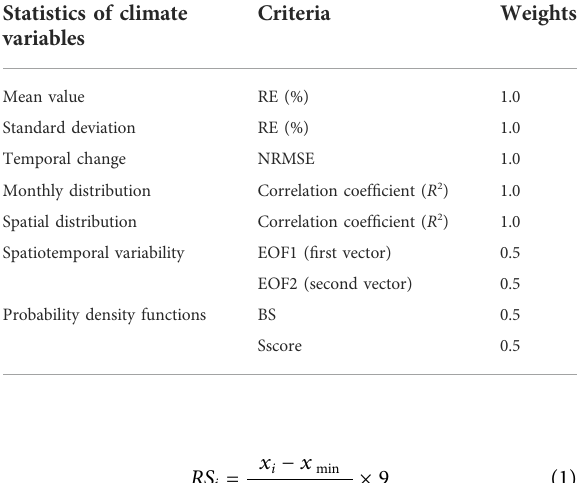
*Convectionschemesareabbreviatedasfollows:KUO(K),Grell(G),Emanuel(E),Tiedtke(T),Kain-Fritsch(KF),Arakawa-SchubertCumulusClosureScheme(AS),andFritsch-Chappell Cumulus Closure Scheme (FC).